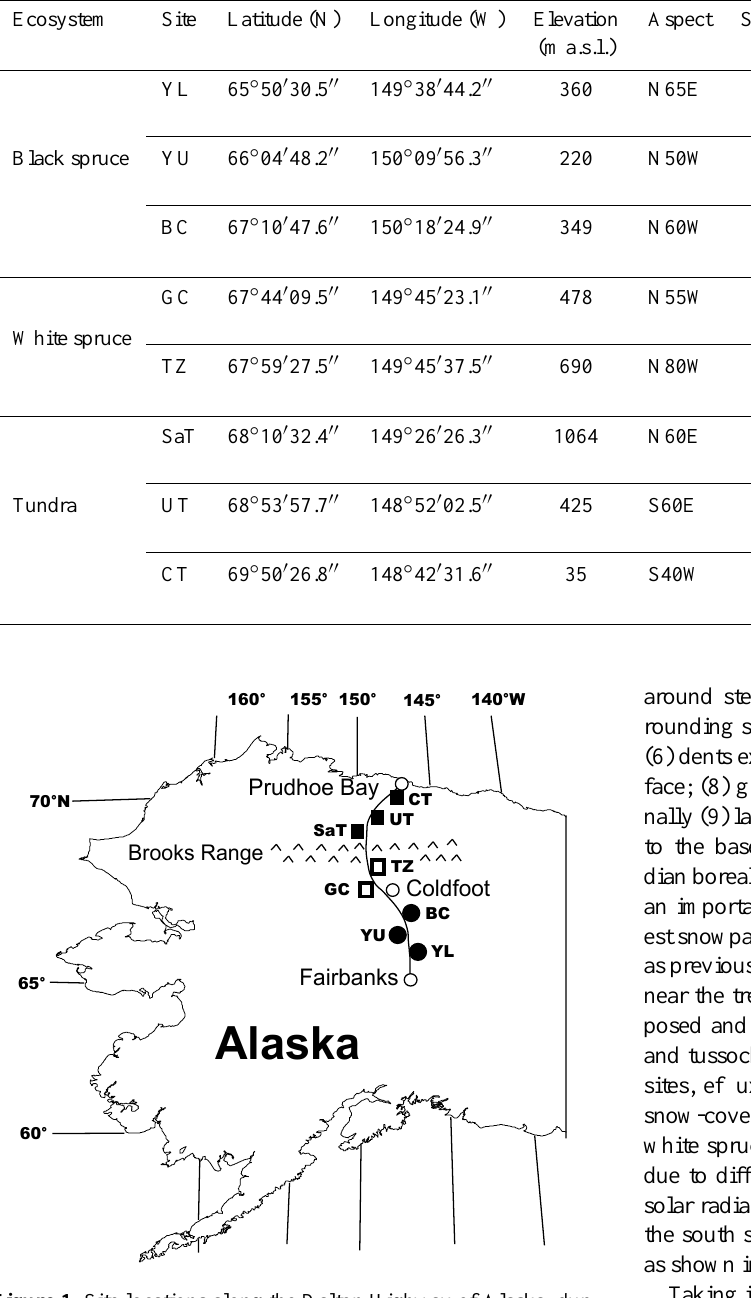
Figure 1. Site locations along the Dalton Highway of Alaska, dur- ing the winter and spring seasons of 2010–2012. Solid circles are black spruce forest sites, open squares are white spruce forest sites, and solid squares denote tundra